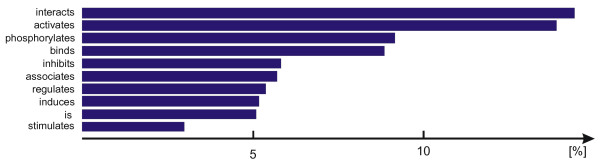
Frequency distribution of relationship types. Relationships were identified from sentence level extraction using LexiQuest Mine (SPSS, Chicago,IL) and patterns developed as previously described [25]. In total, 54 types of relationships were identified. The name and percentage occurrence of the top 10 relationships are shown. The most frequent type of relationship refers to 'interaction' (14.4%); the least frequent type refers to 'homo-oligomerization', featured in only two patterns.